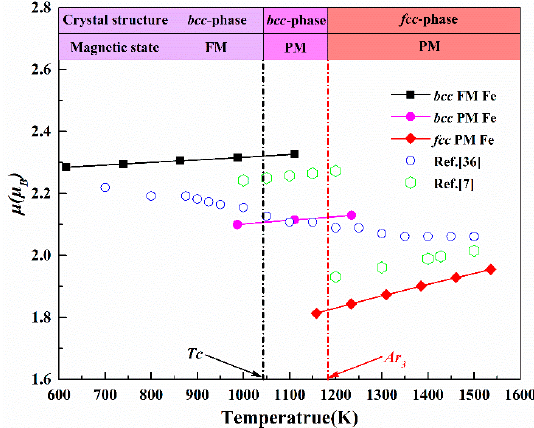
Figure 5. Variation of magnetic moment μ with temperature. The values of present results are plotted as solid symbols connected with lines and the available data from Reference [36] are represented as open symbols.